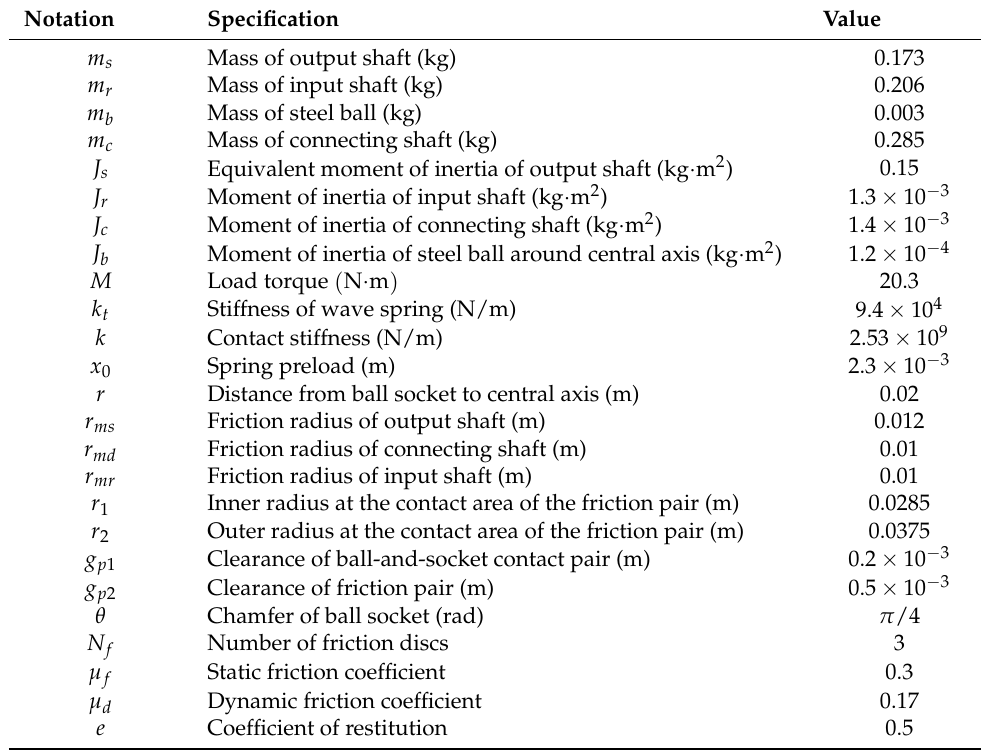
Table 2. Main parameters of the non ‐ return mechanism employed in the simulation.